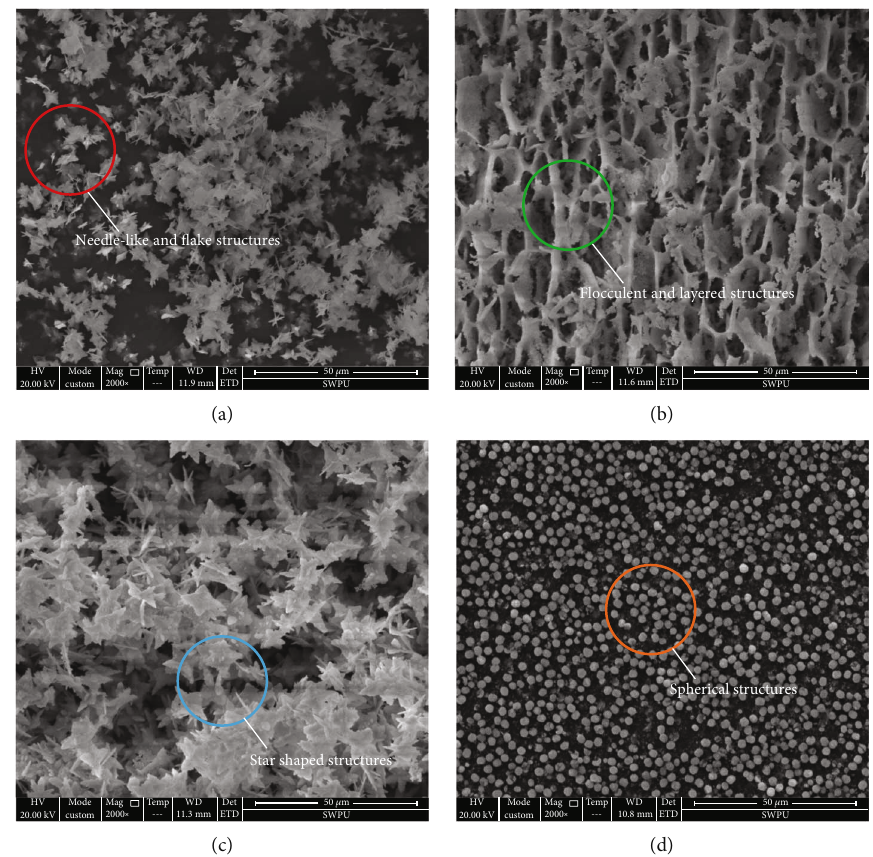
Figure 3: SEM micrographs of BaSO precipitates (a) in the absence of inhibitor, (b) in the presence of 80 mg/L of DTPMP, (c) in the 4 presence of 80 mg/L EDTMPS, and (d) in the presence of 80mg/L DTPA-5Na.